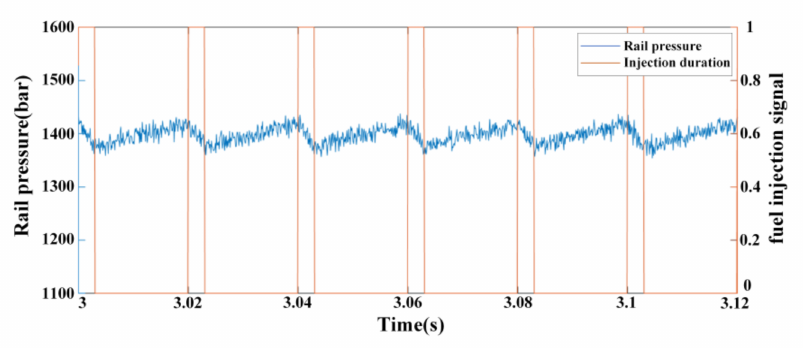
Figure 17. Common rail pressure fluctuation.